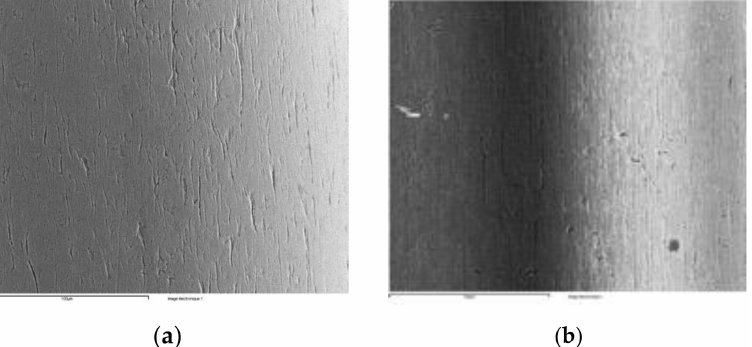
Figure 19. Images of reference hypotube #13(ref): ( a ) before the intergranular test (scale = 100 µ m) and ( b ) after the intergranular test (scale = 100 µ